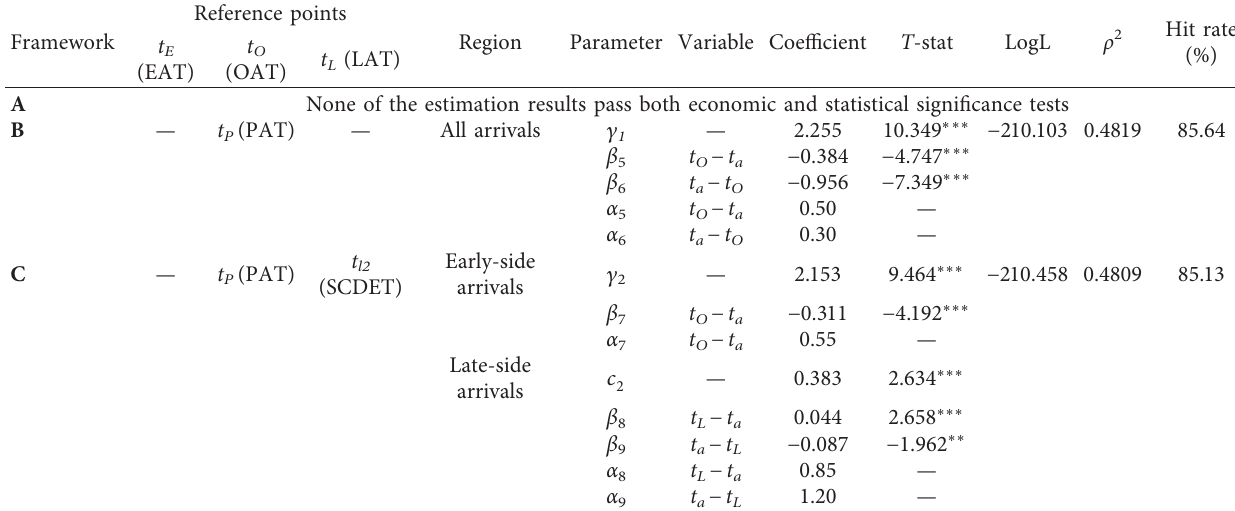
Table 9: The best estimation results of three valuation